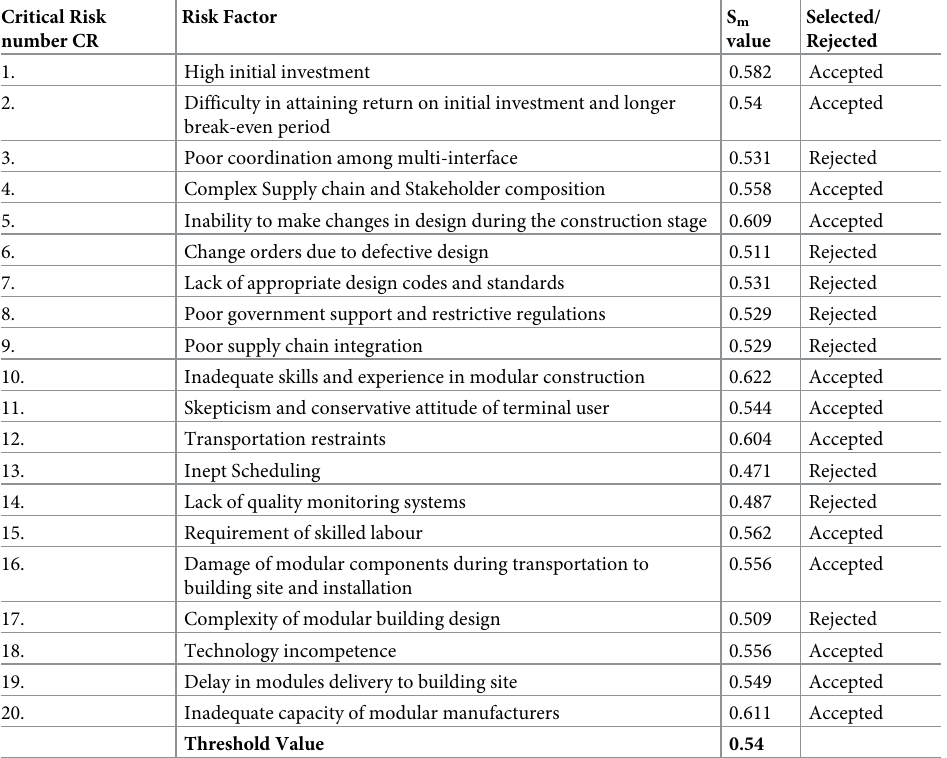
Table 4. Results of Fuzzy Delphi method.